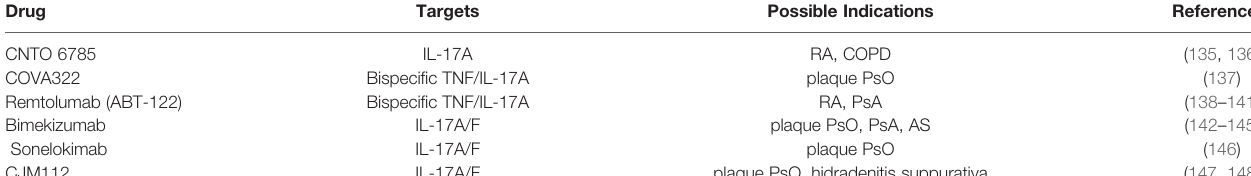
TABLE 3 | Novel drug candidates targeting IL-17A and IL-17A/F.